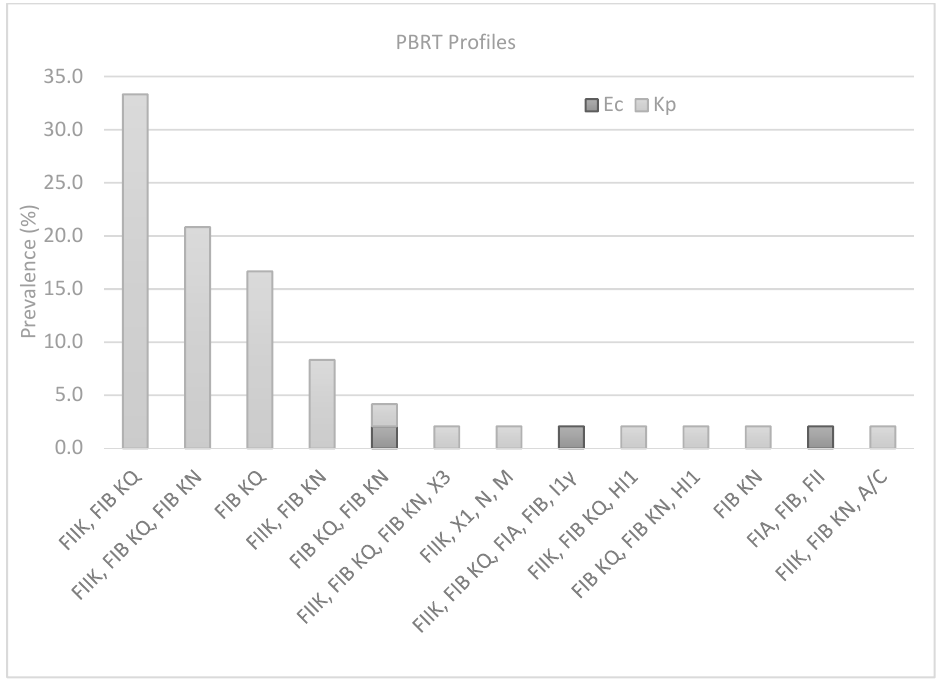
Figure 1. Prevalence of PBRT profiles in K. pneumoniae (Kp) and E. coli (Ec) strains.